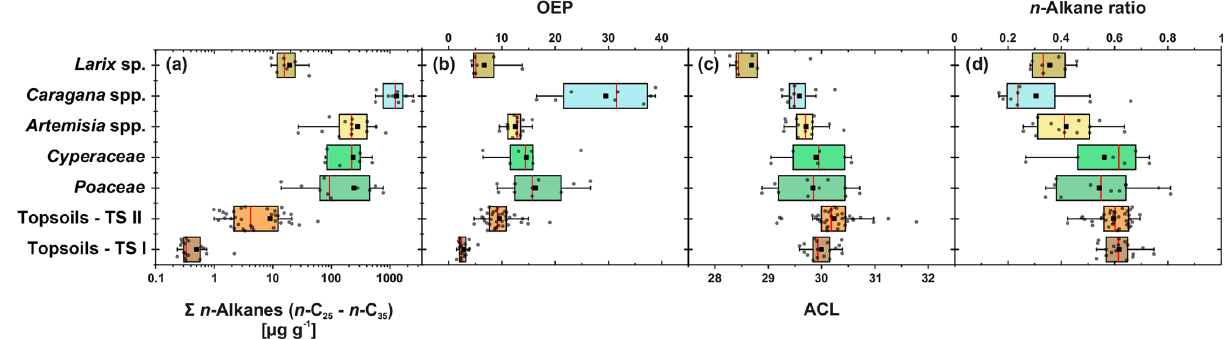
Figure 4. n -Alkane concentration ( n -C 25 − n -C 35 ) (a) , OEP (b) , ACL (c) and n -alkane ratio ( n -C 31 / ( n -C 29 + n -C 31 )) (d) of plants and top- soils from Mongolia ( n : Larix sp. = 7, Cyperaceae = 6, Poaceae = 10, Caragana spp. = 8, Artemisia spp. = 13, topsoils TS I = 17, topsoils TS II = 35). The boxplots indicate median values (red lines), mean values (black squares), interquartile ranges with lower (25%) and upper (75%) quartiles (box), outlier (whiskers), and investigated samples (grey circles). See Table 1 for statistics.